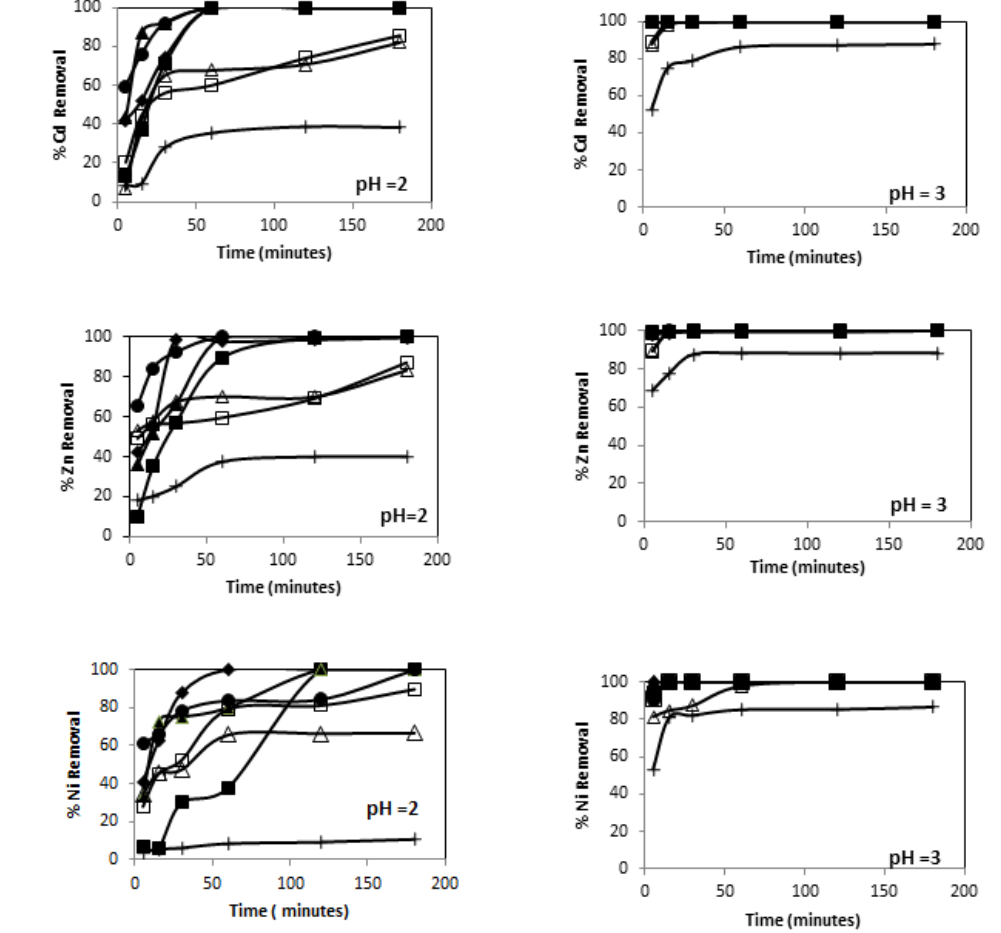
Figure 3. Removal of Zn, Cd, and Ni by bottom ash as a function of initial concentrations at different initial pH: ♦ 50 mg/L; ▪ 100mg/L; ▲ 150 mg/L; ● 200mg/L;□ 250mg/L;Δ 300mg/L; and ┼ 400 mg/L.